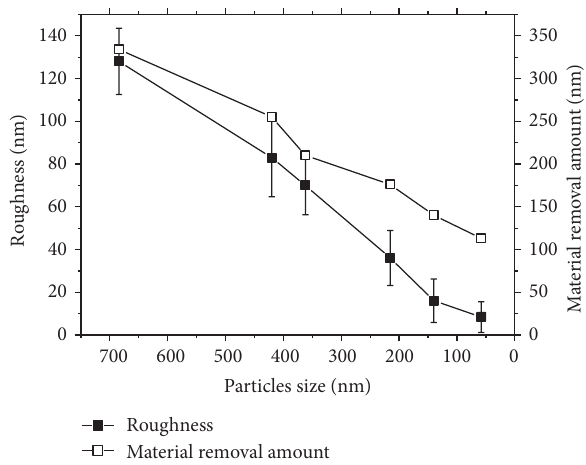
Figure 5: The roughness of steel substrates surfaces and the material removal amount with various sizes of slurries of silica